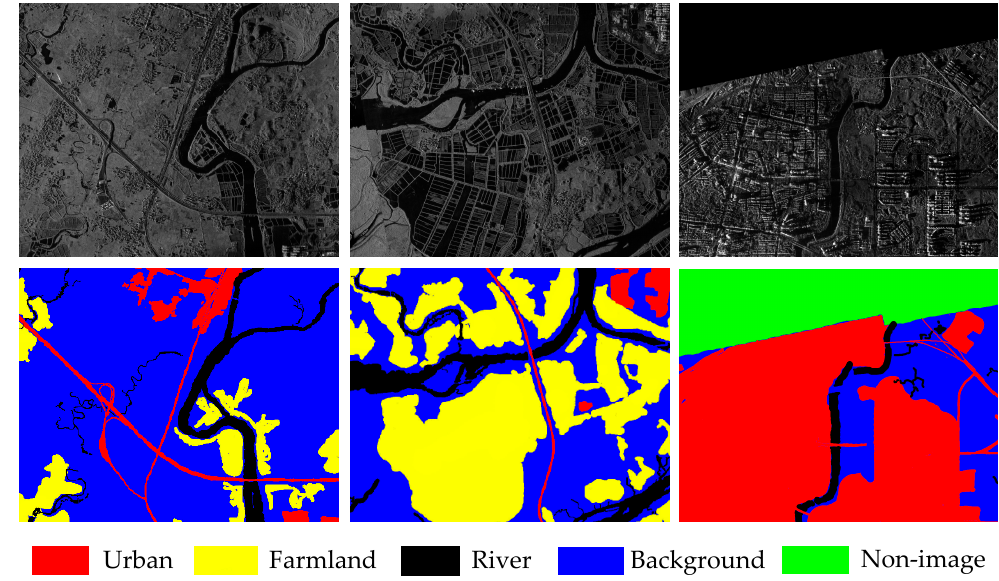
Figure 3. Part of images and the corresponding ground truth.